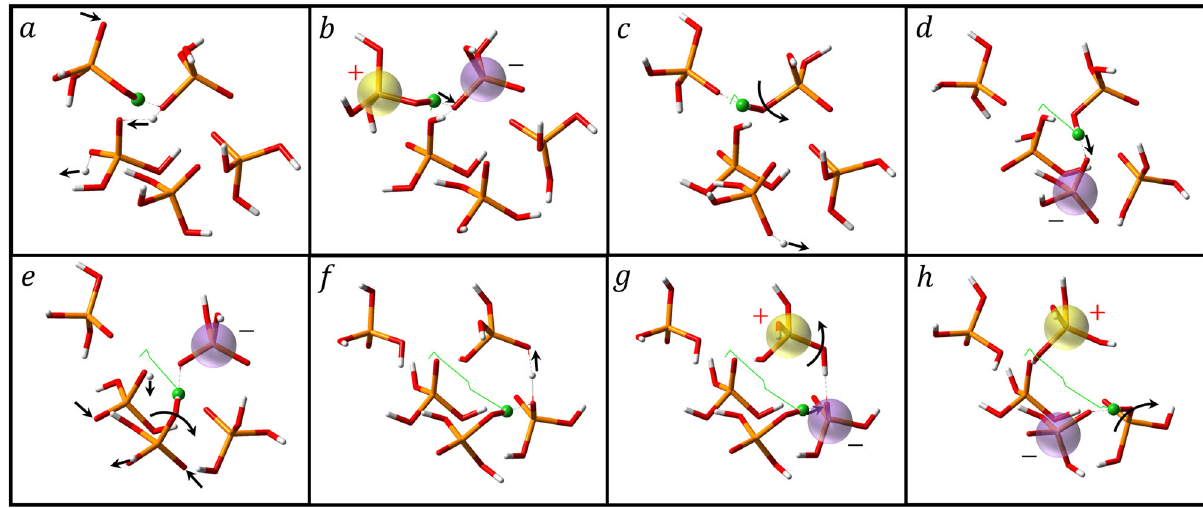
Fig. 9 Snapshots of proton transport. The length of each proton jump between oxygen atoms for a speci fi c proton. The average jump length is very short ~0.5 Å. a – h Snapshots of the elementary steps of the mechanism for long-range proton diffusion in pure PA. The charged entities are highlighted. The collaboration of proton transfers a , b , d , f , g and large angular jumps c , e , h facilitates the long-range diffusion of protons. See the text for a detailed